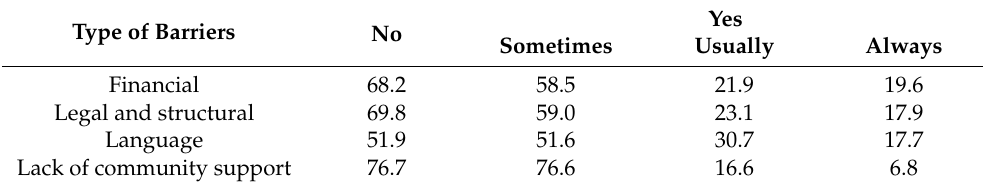
Table 3. Perceived barriers to accessing the healthcare